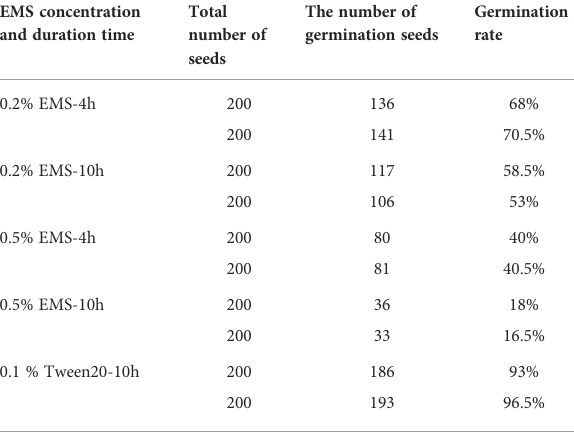
TABLE 1 The germination rate of different EMS concentration treatment.